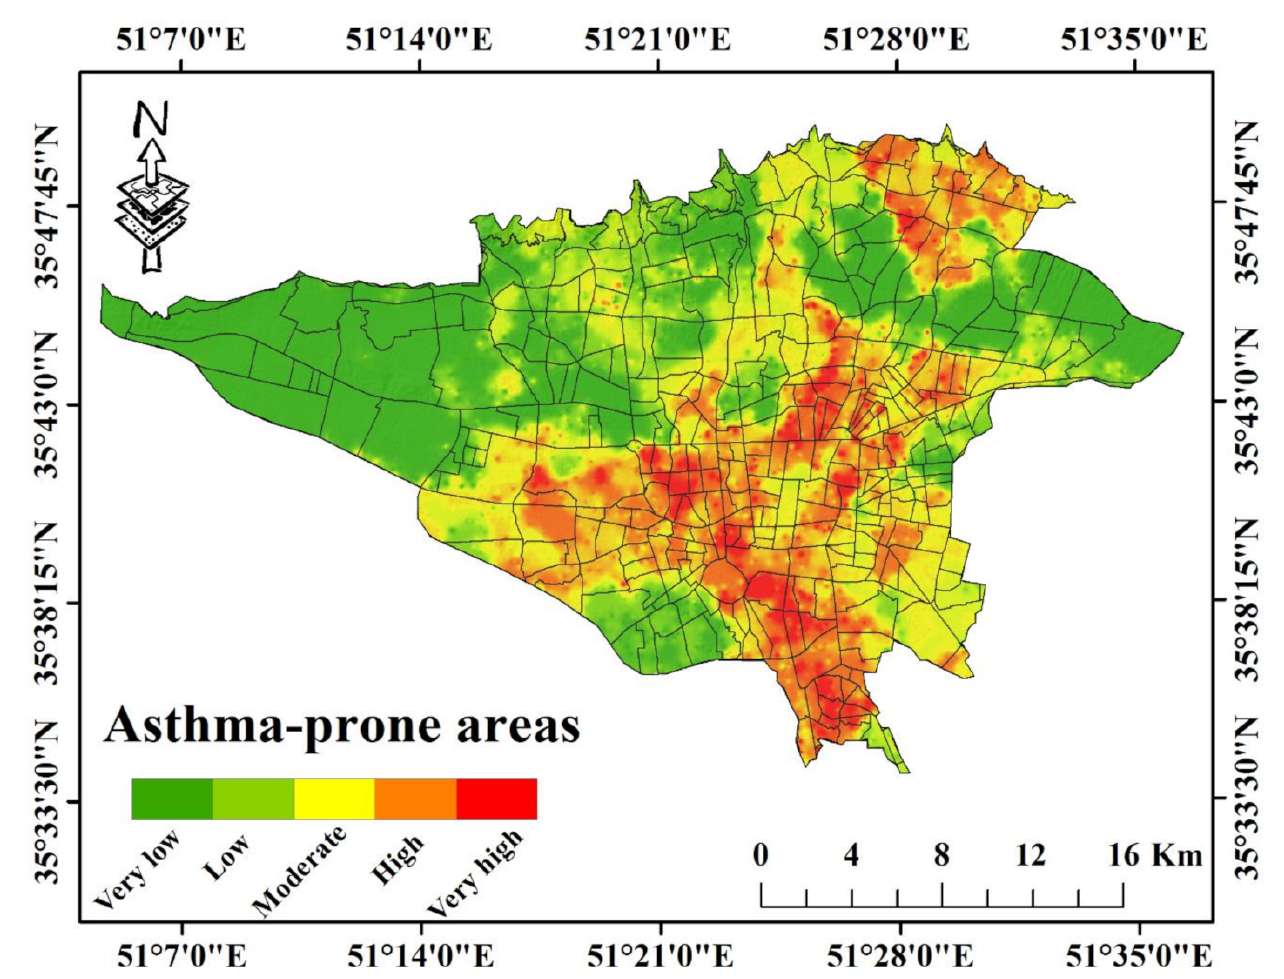
Figure 6. Asthma-prone areas map by the AdaBoost